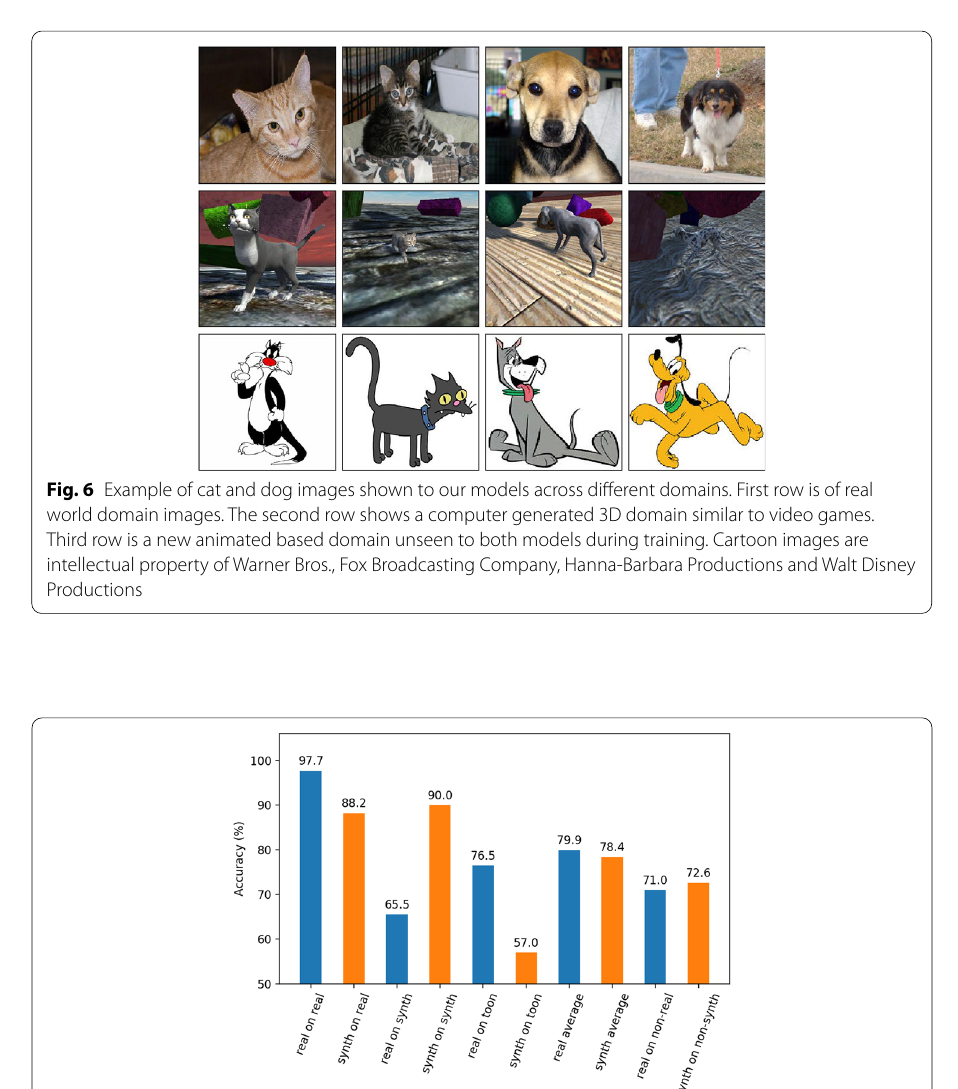
Fig. 7 Optimal accuracy of the real and synthetic model across a variety of different